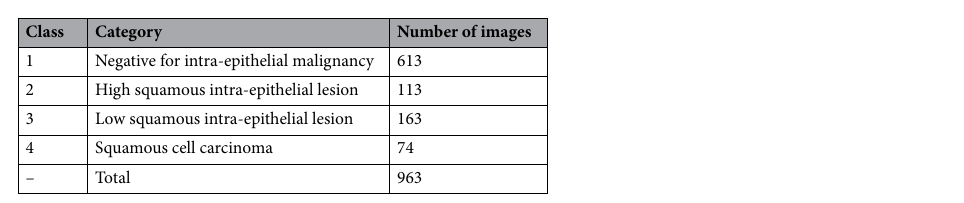
Table 2. Distribution of images in the Mendeley LBC smear dataset.